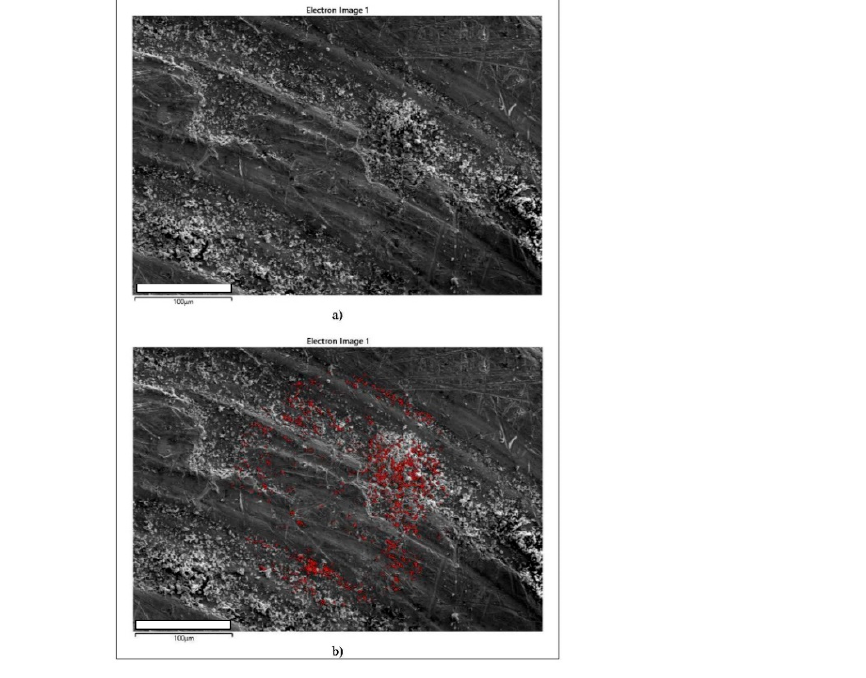
Figure 5. SEM of the as-cast state sample (L) after 420 min of cavitation exposure (the scale bar: 100 μ m)